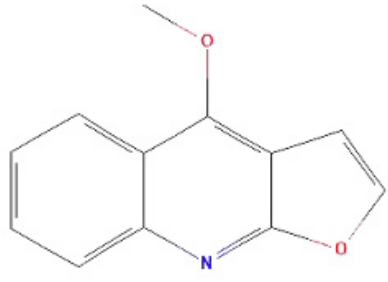
Figure 1. Chemical structure of